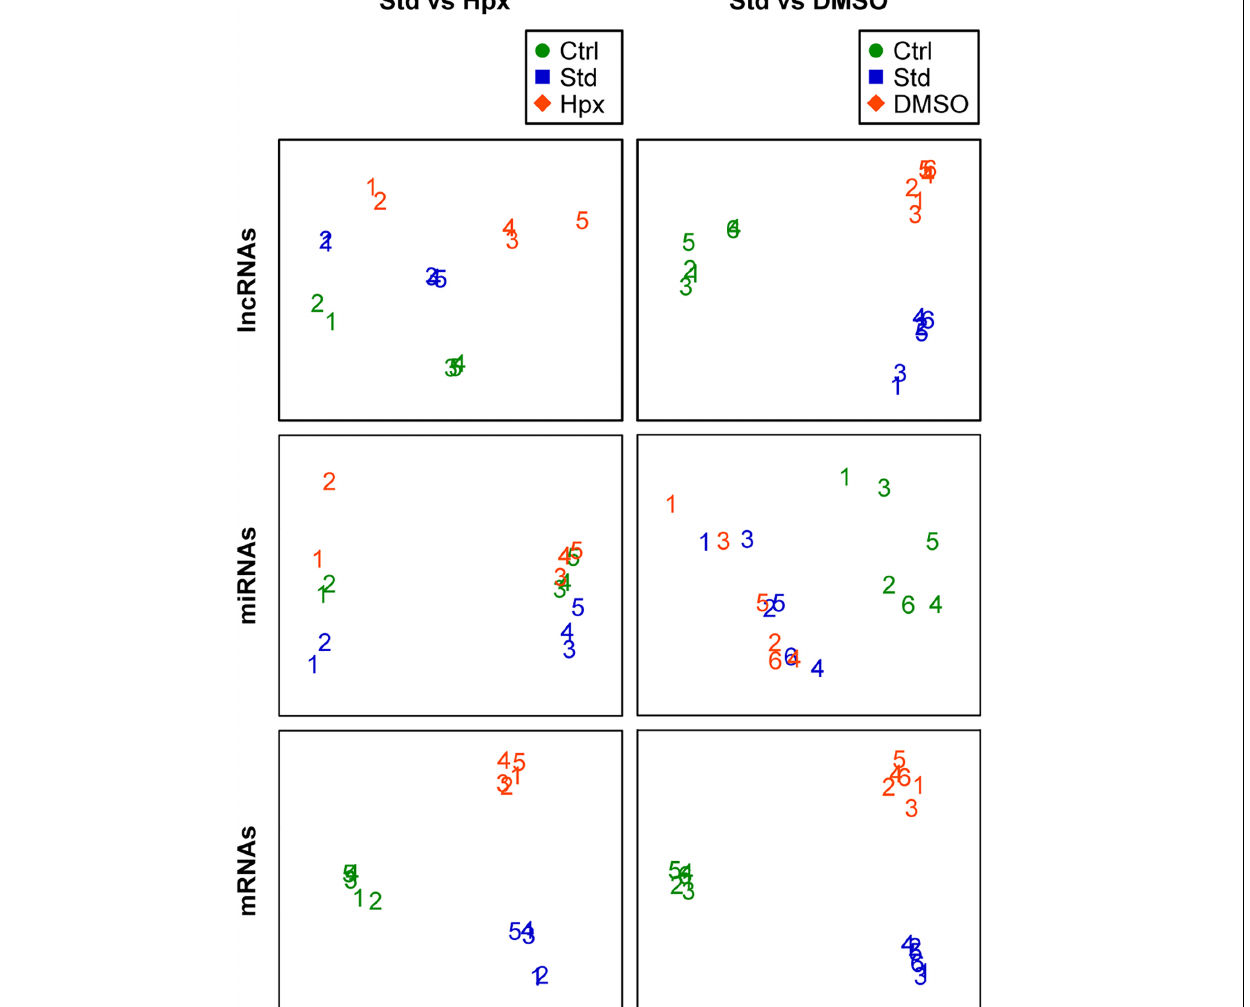
performed indirect gene ontology analysis as described in section “Materials and Methods.” We first selected the 438 hypoxia-DE